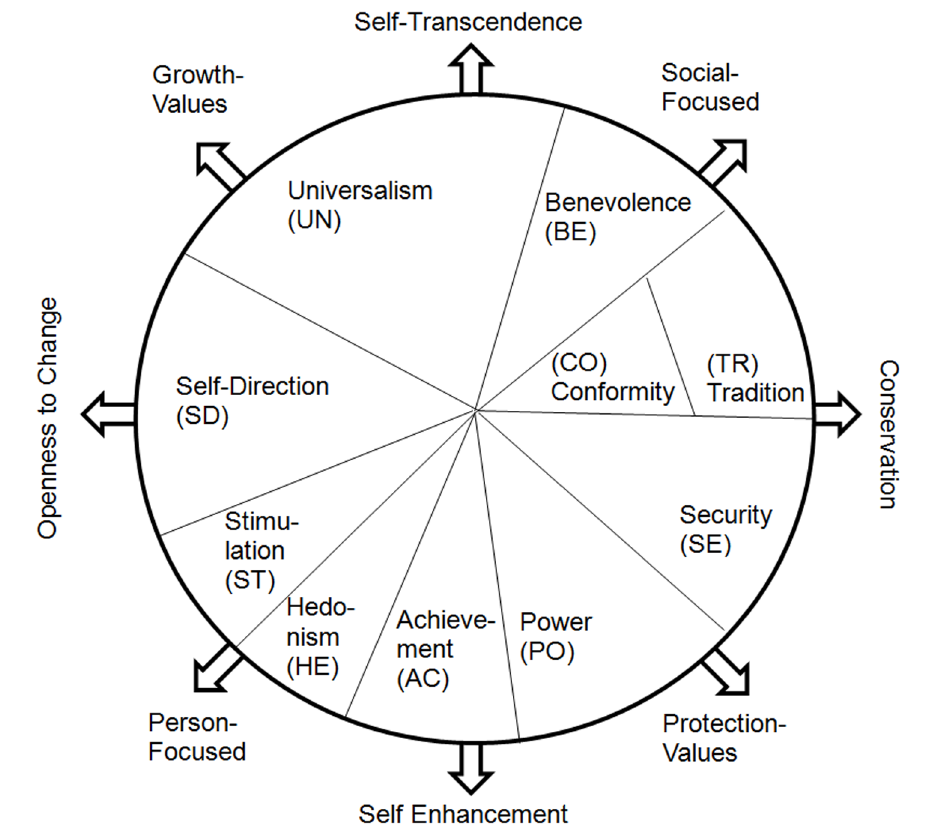
Figure 1. The Value Circle (structure of value types according to Schwartz, 1992, and diagonal axes according to Schwartz,